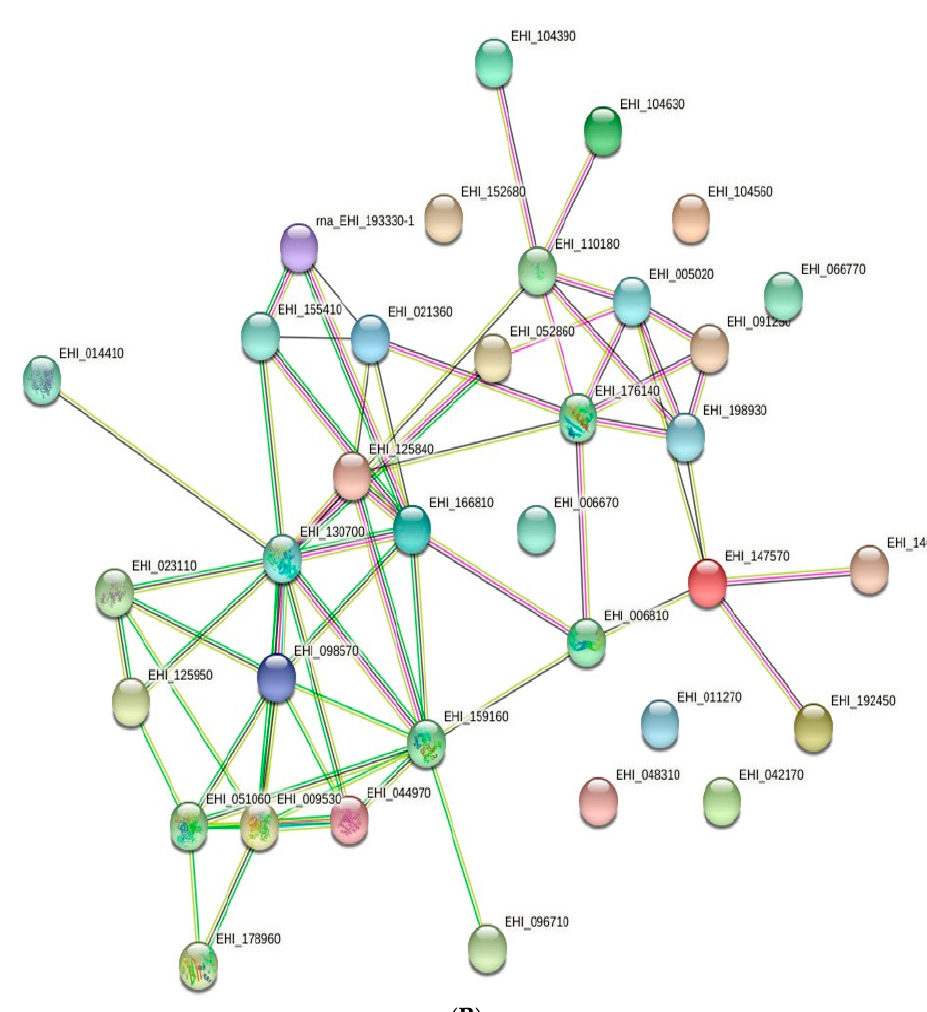
Figure 4. STRiNG generated networks of increased and decreased abundance proteins. ( A ) Increased abundance proteins comprised membrane and cytosolic proteins. Proteins with accession no. in the red boxes are membrane proteins. Meanwhile, proteins with accession no. without red boxes are cytosolic proteins. ( B ) Decreased abundance proteins comprised cytosolic proteins. Table 4. Line colors explanation.